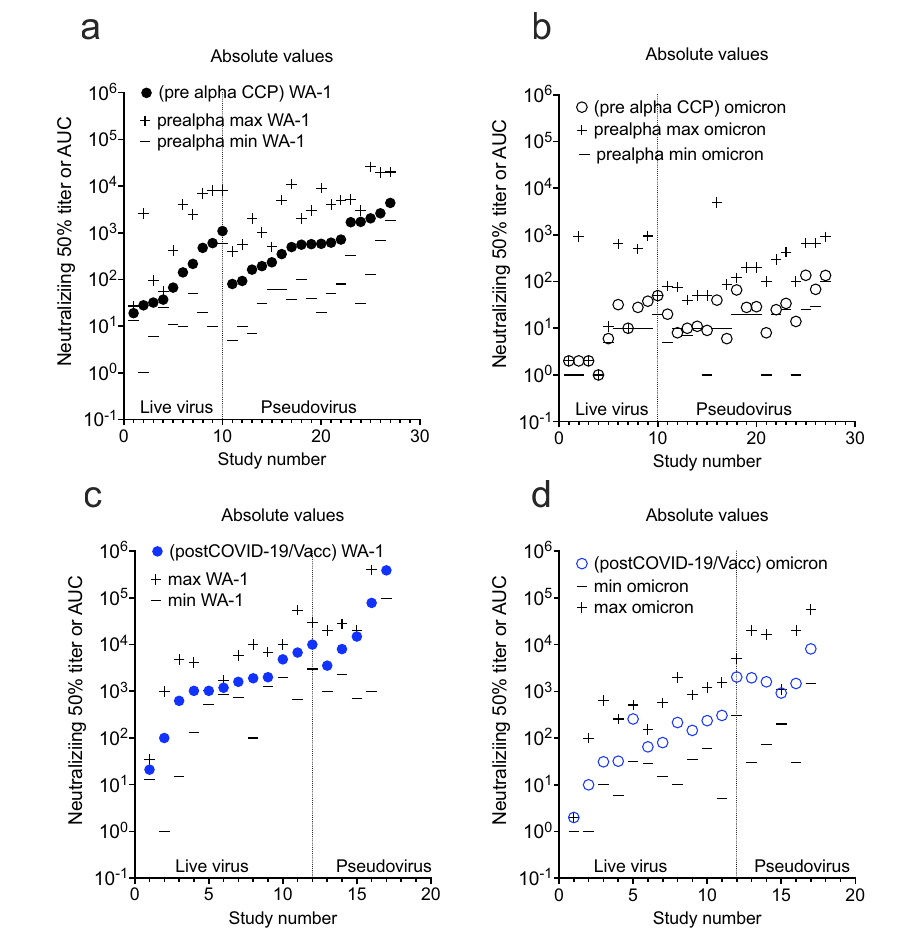
Fig.6|GMT 50 fromeachstudywithminimumandmaximumdilutiontiteralso shown. Live virus assays are on the left and pseudovirus assays on the right. a pre- alpha CCP against WA-1, b pre-alpha CCP against omicron BA.1, c post COVID-19/